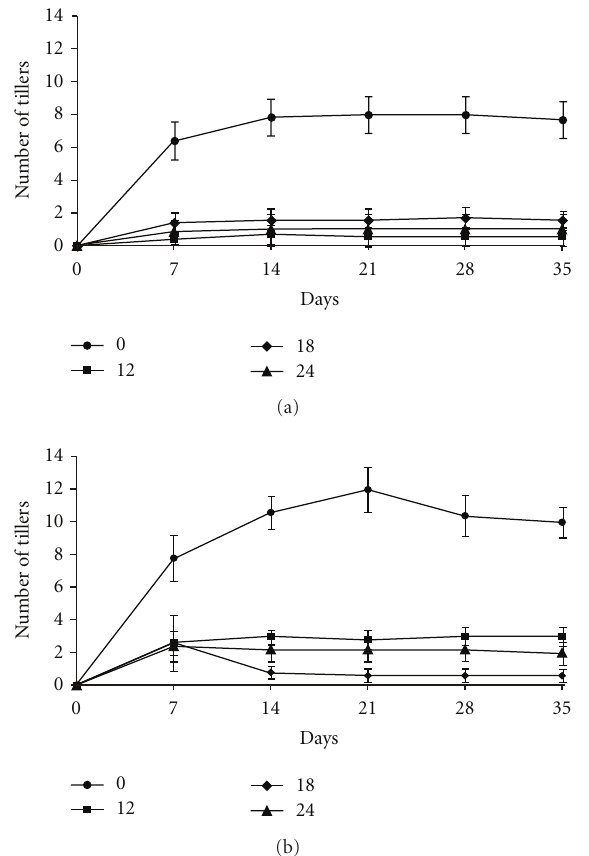
Figure 5: Number of tillers after the B. ruziziensis plants were cut and subjected to di ff erent levels of infestation by M. spectabilis adults over 5 (a) or 10 (b)